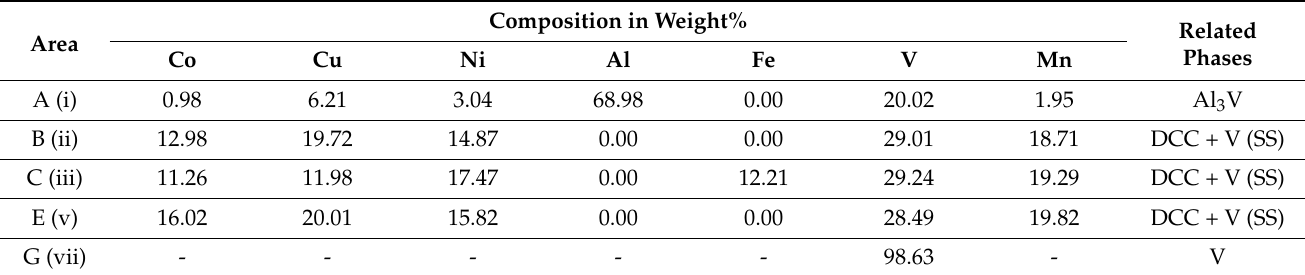
Table 3. EDS results with respect to different areas in the weld zone.